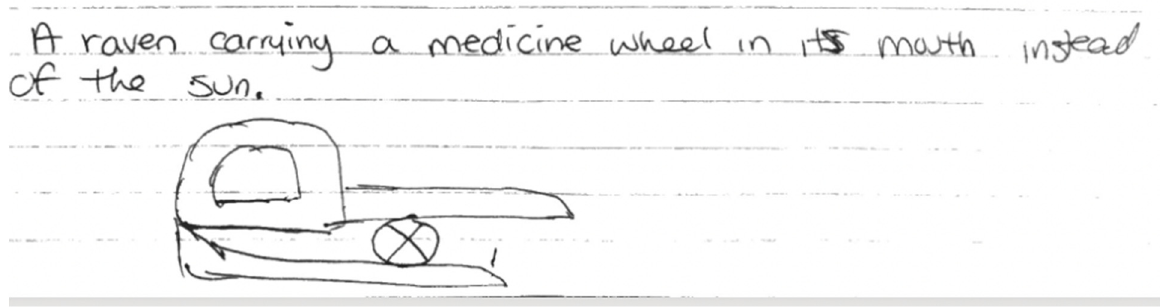
Figure 3. An Indigenous Interface Design Usability Preference, The Raven and the Sun.